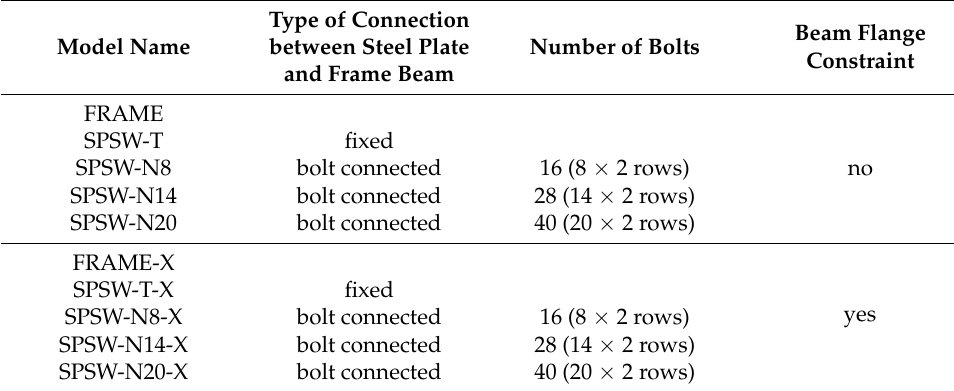
Figure 9. Partial models: ( a ) SPSW-N8; ( b ) SPSW-T; ( c ) FRAME.